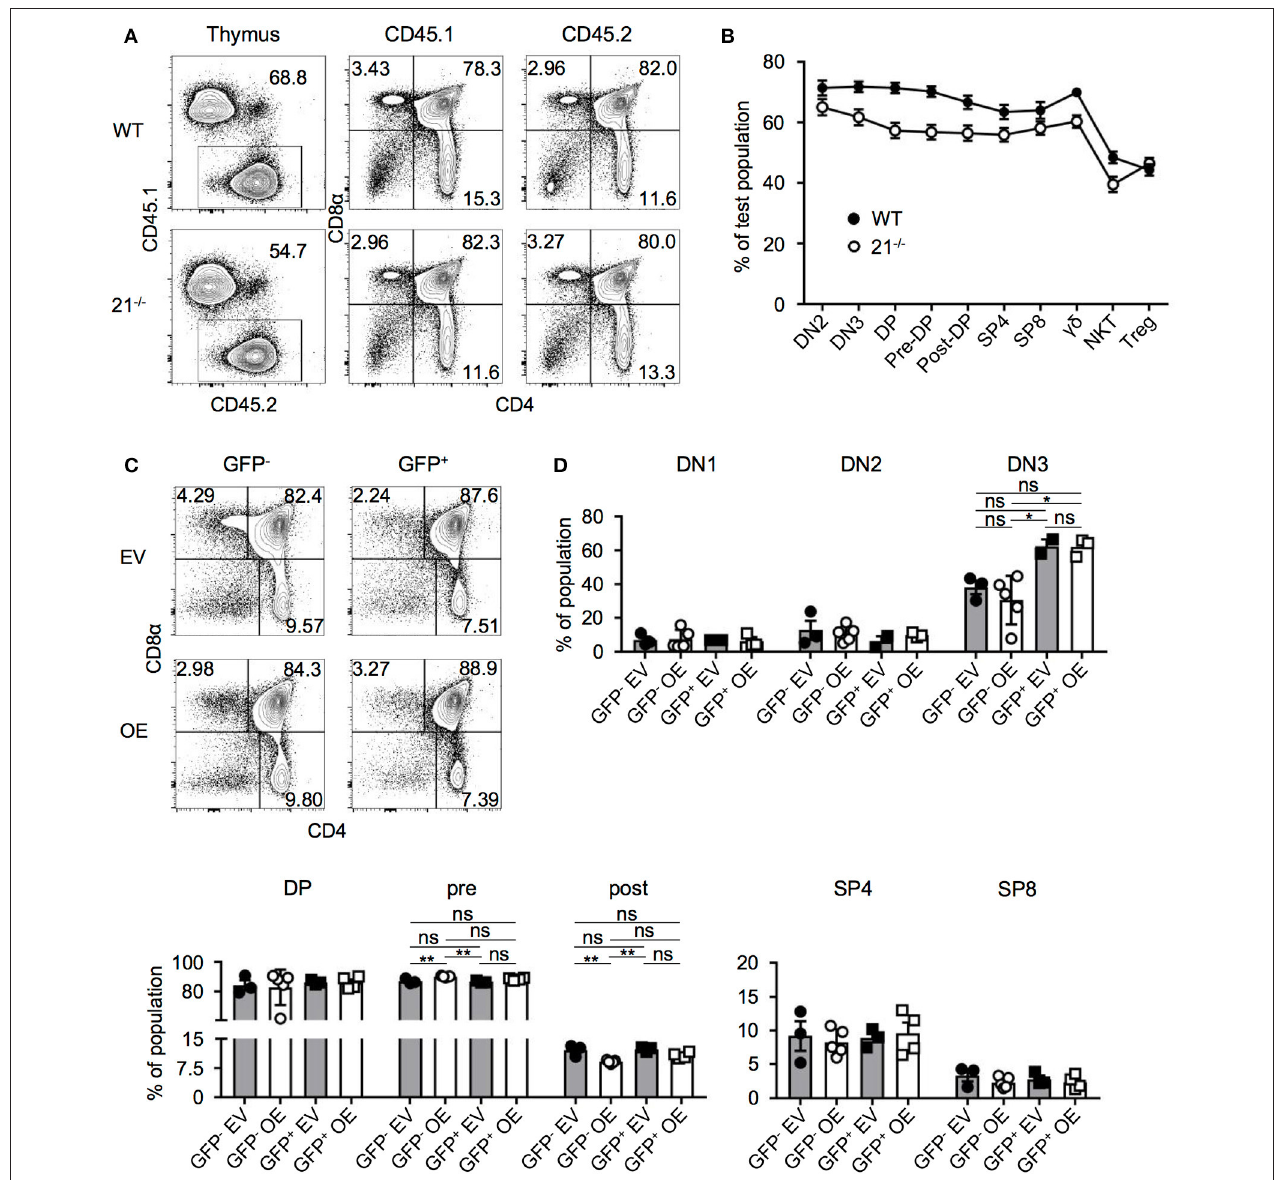
FIGURE 5 | miR-21-deficiency or overexpression do not alter T-cell development in BM chimeras. (A) Representative flow cytometric analysis of competitive BM chimeras 8 weeks after transfer, CD45.1: competitor population; CD45.2: test population (WT control or miR-21 − / − ). Thymi were stained with antibodies against CD45.1, CD45.2, CD4, and CD8 α . Numbers adjacent to gates and in quadrants represent frequencies. (B) Comparative analysis of thymocyte subpopulations in CD45.2 test populations (WT control or miR-21 − / − ) of competitive chimeras, n = 9 per group. (C) Representative flow cytometric analysis of overexpression chimeras 8 weeks after transfer. Thymi were stained with antibodies against CD4 and CD8 α . Left panels display distribution of GFP − (untransduced) thymocytes in EV (empty vector) control or OE (miR-21-overexpression) chimeras. Right panels indicate GFP + (transduced) thymocytes. Numbers in quadrants represent frequencies. (D) Statistical analysis of flow cytometric results of DN1, DN2, DN3, DP, pre- and post-selection DP, SP4, and SP8 populations from GFP − EV, GFP − OE, GFP + EV, GFP + OE thymocyte subsets indicated as frequencies, inter alia shown in (C) , n = 2-5. Analysis of significance were performed using one-way analysis of variance followed by Tukey’s test. Indicated significant results are representative of latter